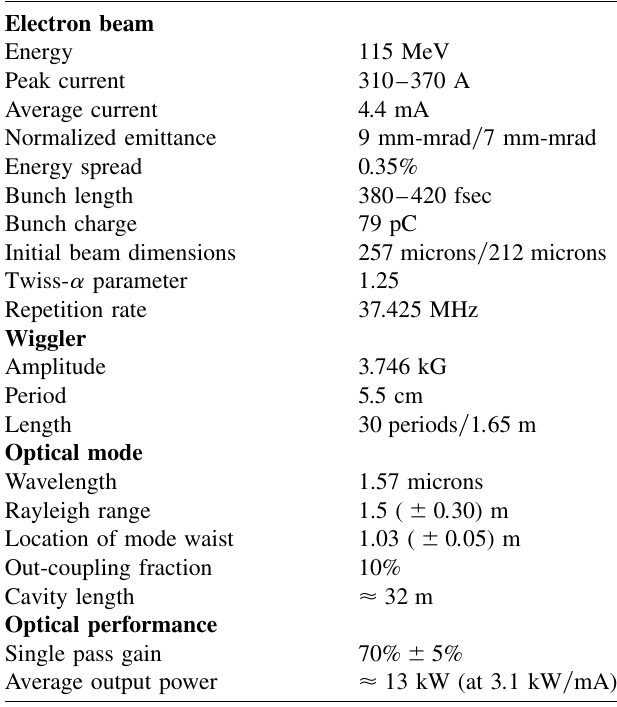
SIMULATION OF A HIGH-AVERAGE POWER . . TABLE I. Nominal experimental parameters for operation at 1 : 6 (cid:6) m .